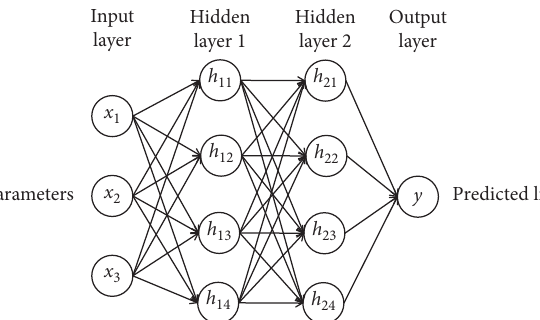
Figure 3: The structure of the neural